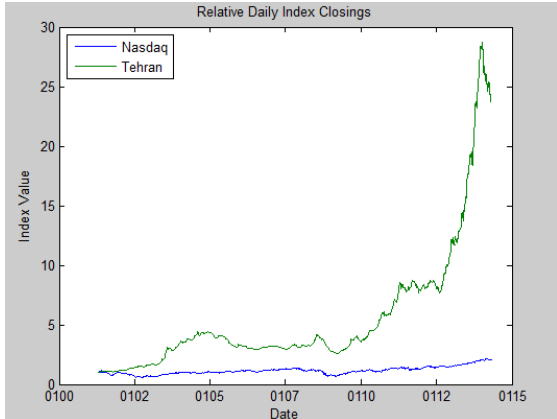
Fig. 1. Relative Price movements of each